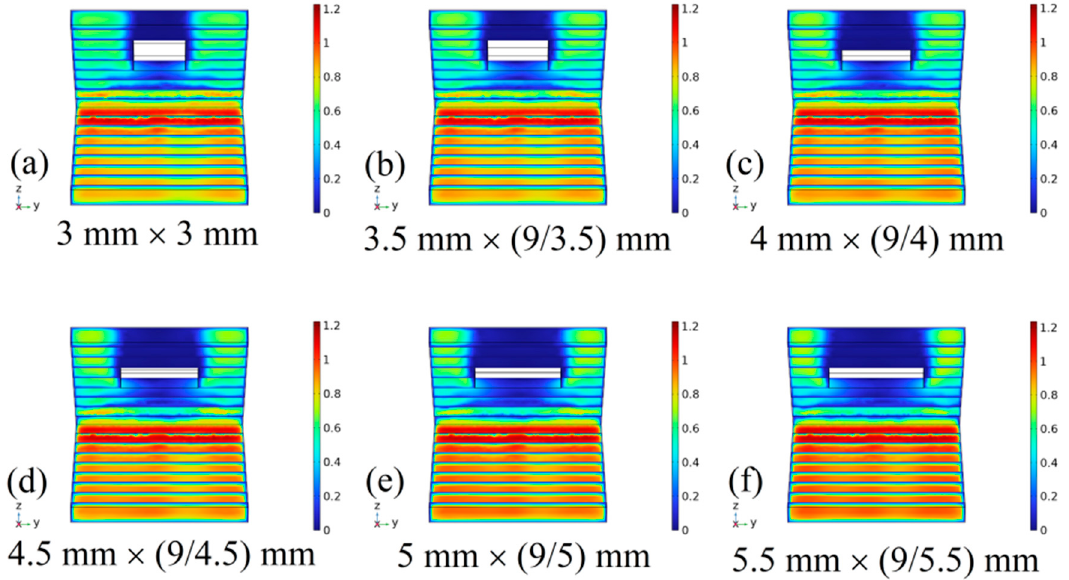
Figure 10. Velocity variations in the bifurcated fracture B for a constant contact area of the contact area is 9 mm 2 (velocity: m/s). ( a – f ): Velocity variations in the bifurcated fracture B for a constant area of 9 mm 2 with different contact cross-sections. Table 4. Velocity variations in the two bifurcated fractures for different contact areas (cross-section is 3 mm).